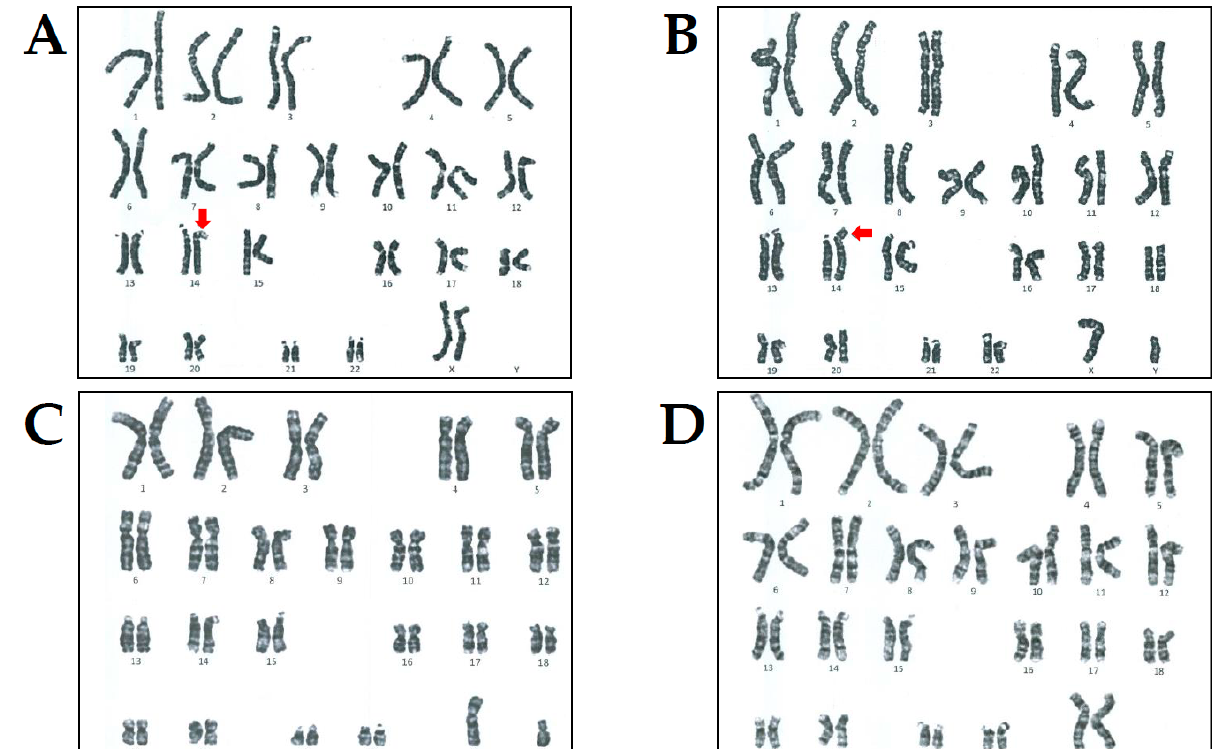
Figure 2. Results of chromosomal analysis in the proband and her family members. Chromosomal analysis revealed 46,XX,der(14)t(14;14)(p11.2;q32.1) in the proband ( A ) and 46,XY,der(14)t(14;14)(p11.2;q32.1) in her elder brother ( B ) as indicated by the red arrow, respectively. However, their father ( C ) and mother ( D ) showed normal karyotyping.